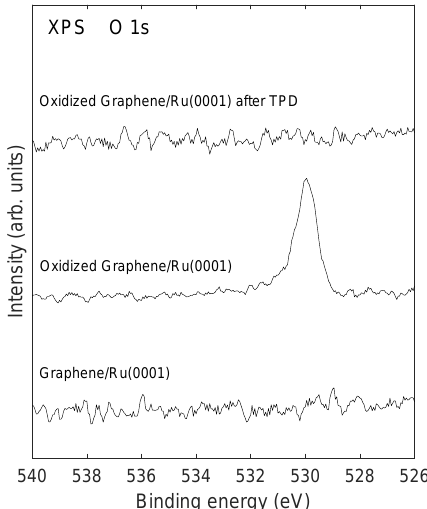
Figure 8. XPS from the O1s core level for: (bottom spectrum) Graphene/Ru(0001); (middle spectrum) oxygen exposed Graphene/Ru(0001); and (top spectrum) oxidized Graphene/Ru(0001) after anneal- ing to 1000 K. The graphene layer was produced by four ethylene exposure cycles as described in the